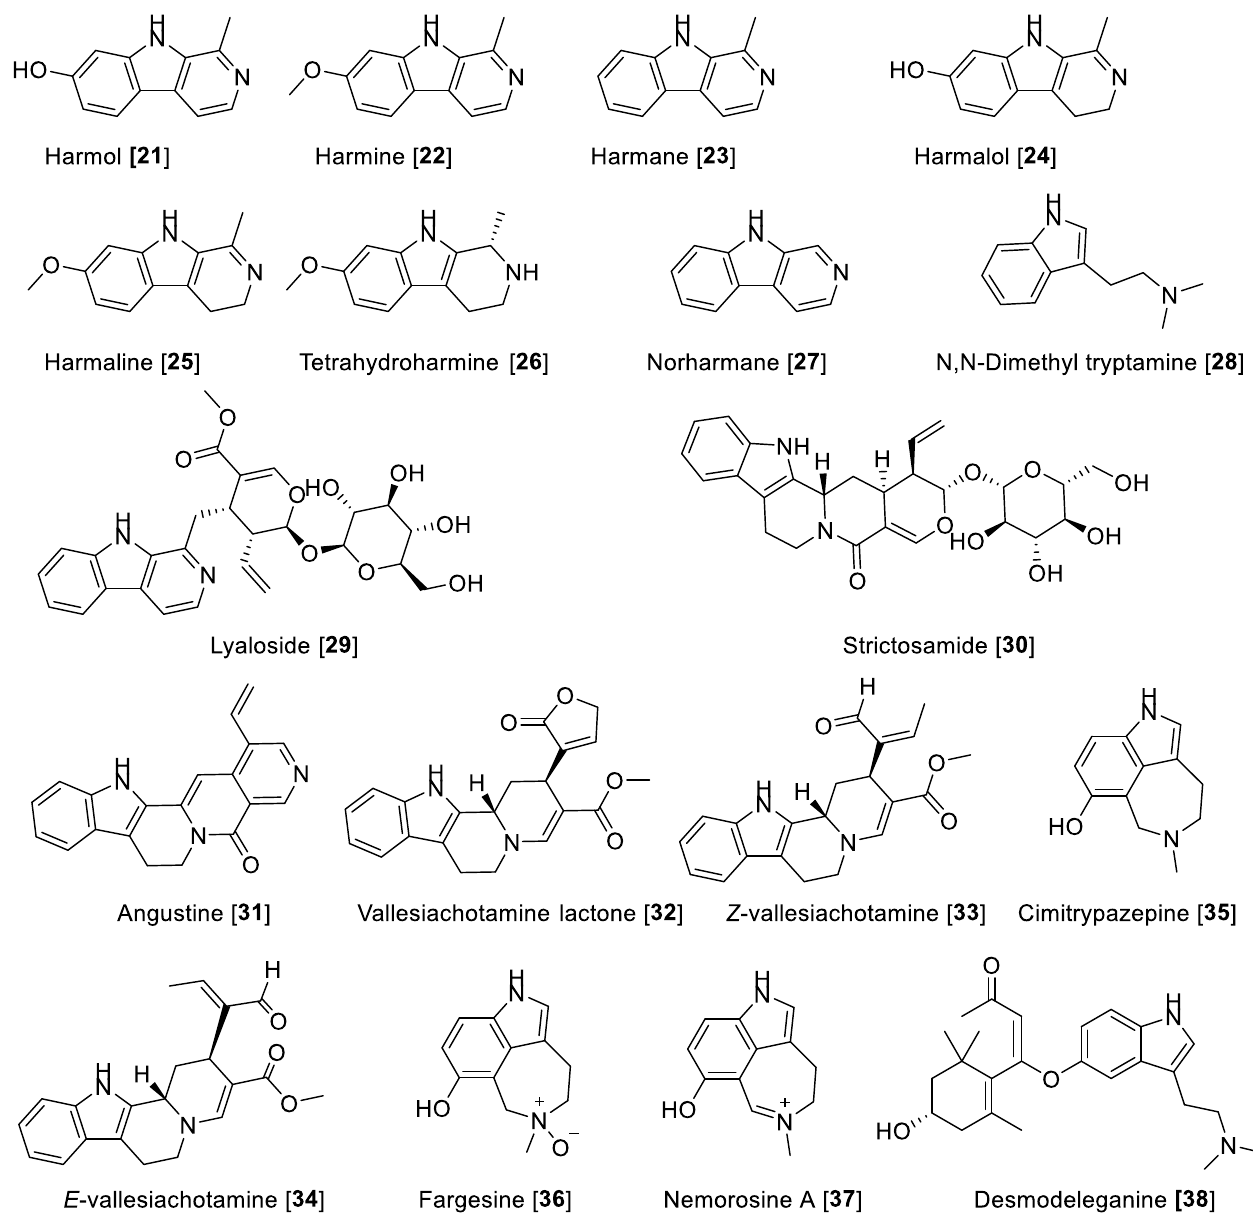
Figure 5. Chemical structure of selected alkaloid MAO inhibitors with indole motif. Table 2. Alkaloid natural product inhibitors of MAO-A and MAO-B.